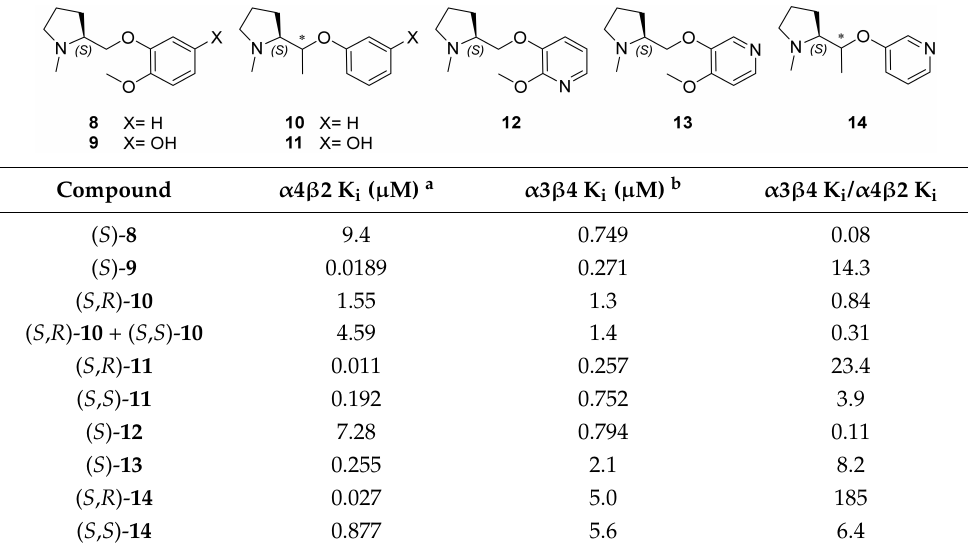
Table 2. Binding affinity data at α 4 β 2 and α 3 β 4 nAChRs and α 4 β 2 vs. α 3 β 4 selectivity ratio of compounds 8 – 14 reported in Bolchi et al. [32]. a Tested at rat cortex using [ 3 H]-epibatidine. b Tested at membranes of human α 3 β 4 transfected